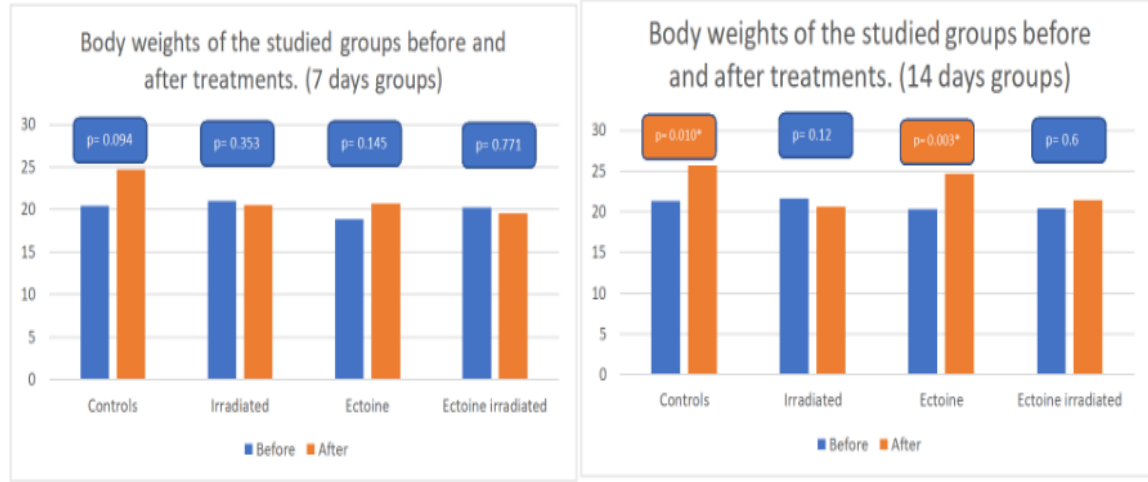
Fig. 3. Body weights of the studied groups before and after treatments.